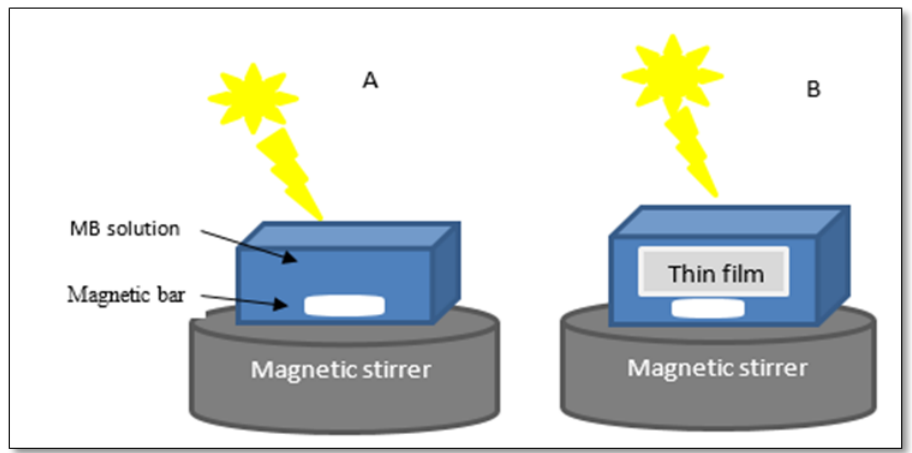
Fig. 1: The experimental schematic for photocatalytic degradation of MB solution (A) MB solution without catalyst (B) MB with nanostructured ZnO thin film.